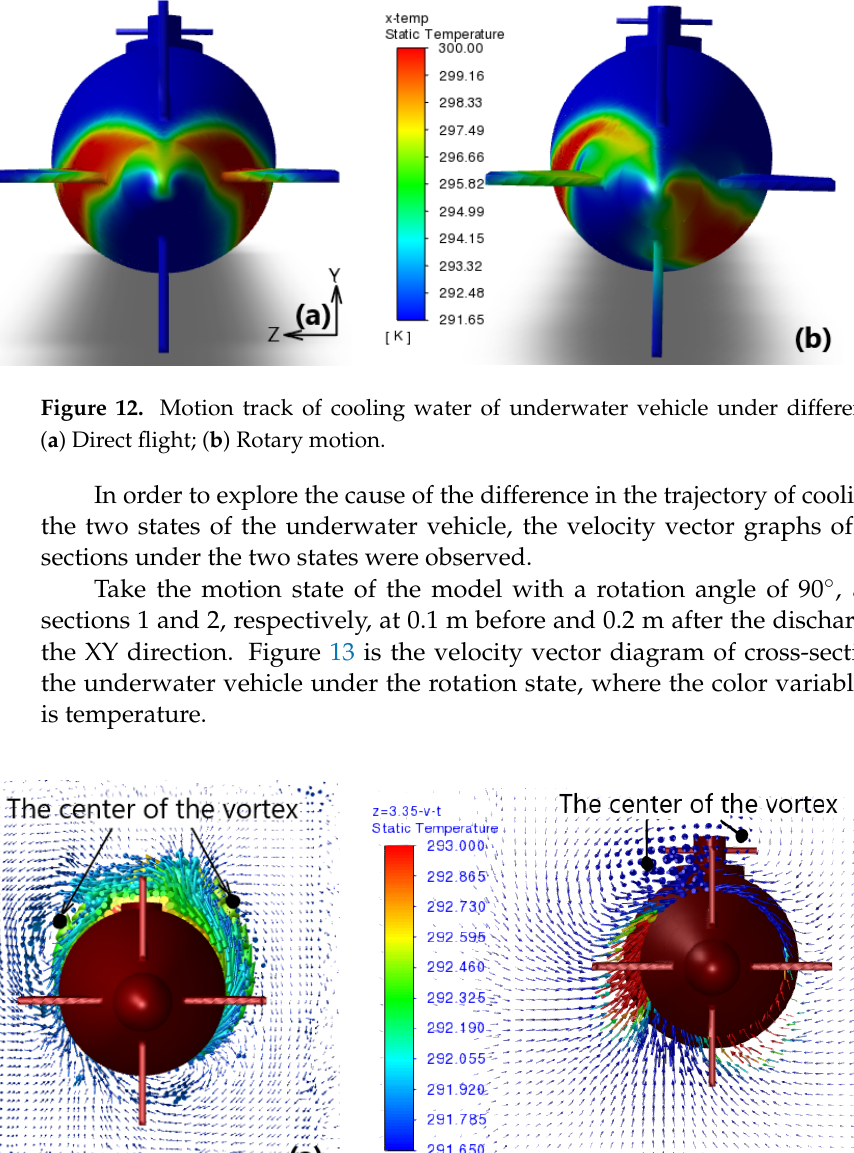
Figure 13. Velocity vector diagram of sections one and two of the underwater vehicle under the rotating state: ( a ) Direct flight; ( b ) Rotary motion.